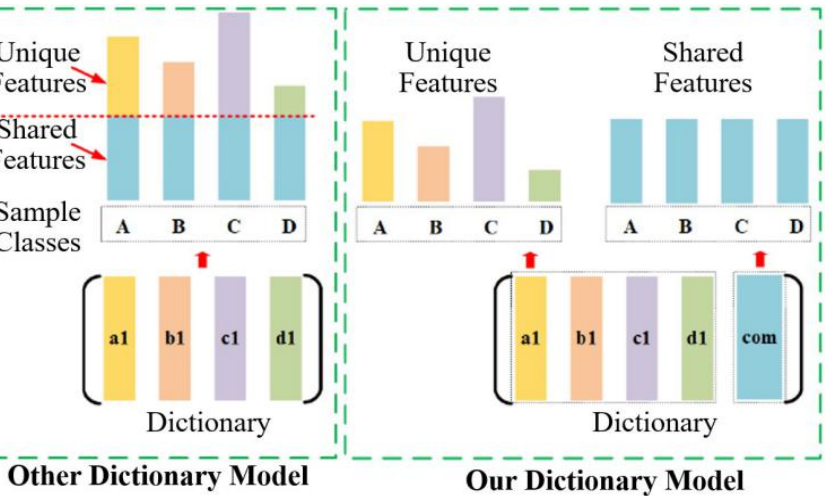
Figure 3. Overview of the built dictionary of the developed model. Shared constraints are used to describe the common features of all classes of HSI